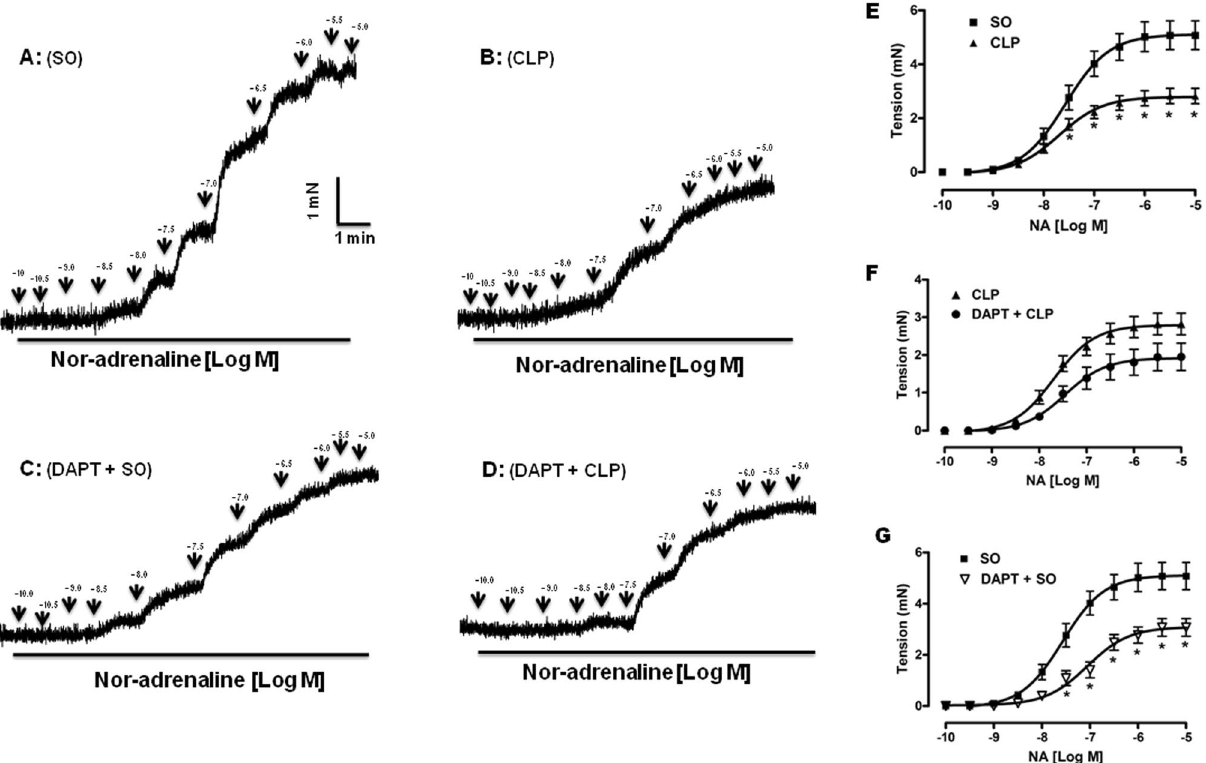
Figure 8. Effect of DAPT pre-treatment on hyporeactivity of the aortic ring to nor-adrenaline (NA) in septic mice. Representative tracings show the concentration-dependent contractile response to NA (0.1 nM–1 µM) in the aorta from sham-operated (SO; A ), sepsis (CLP; B ), DAPT pre-treated SO (DAPT + SO; C ) and DAPT pre- treated sepsis (DAPT + CLP; D ) groups. Comparative line diagrams ( E – G ) showing the mean concentration– response curves of NA from different groups. Data are presented as mean ± SEM; n = 6. Vertical bars represent SEM. Data were analyzed by two-way ANOVA followed by Bonferroni post-hoc tests. * p < 0.05 in comparison to